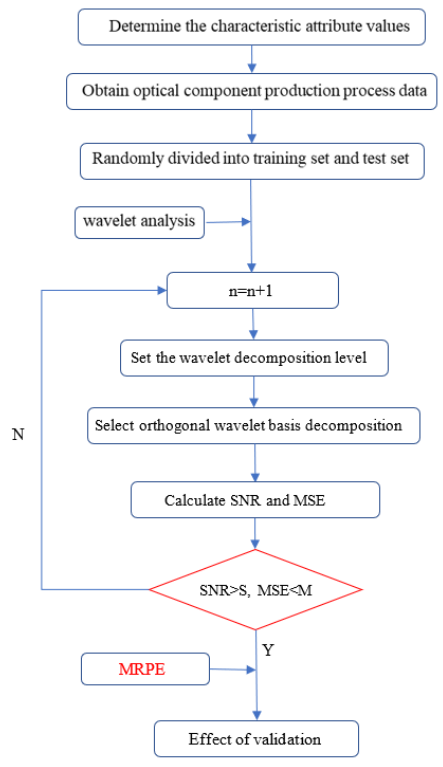
Figure 4. Method flow chart.